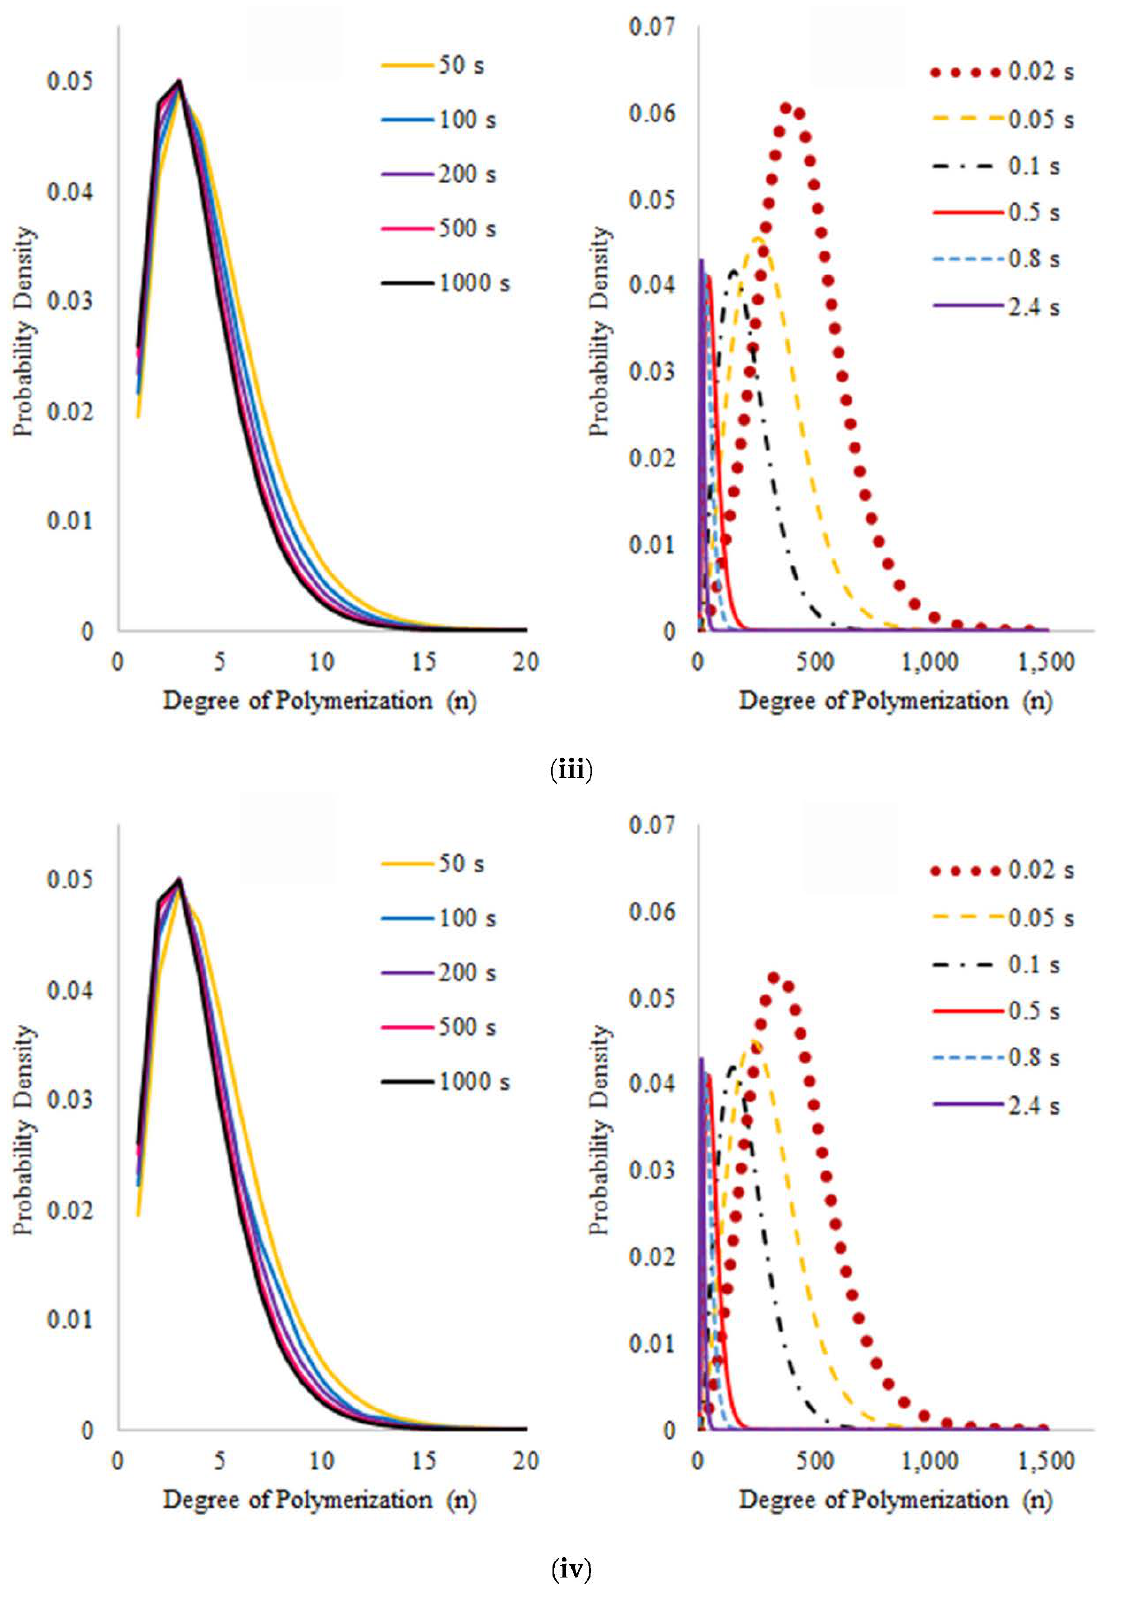
Figure 12. Molecular Weight Distributions of ( i ) dead chains (D), ( ii ) dormant chains (S), ( iii ) living chains (P), and ( iv ) living chains with nitroxide (D) in the simulation of the pyrolysis of PS synthesized via NMP, (N/I = 1.3).